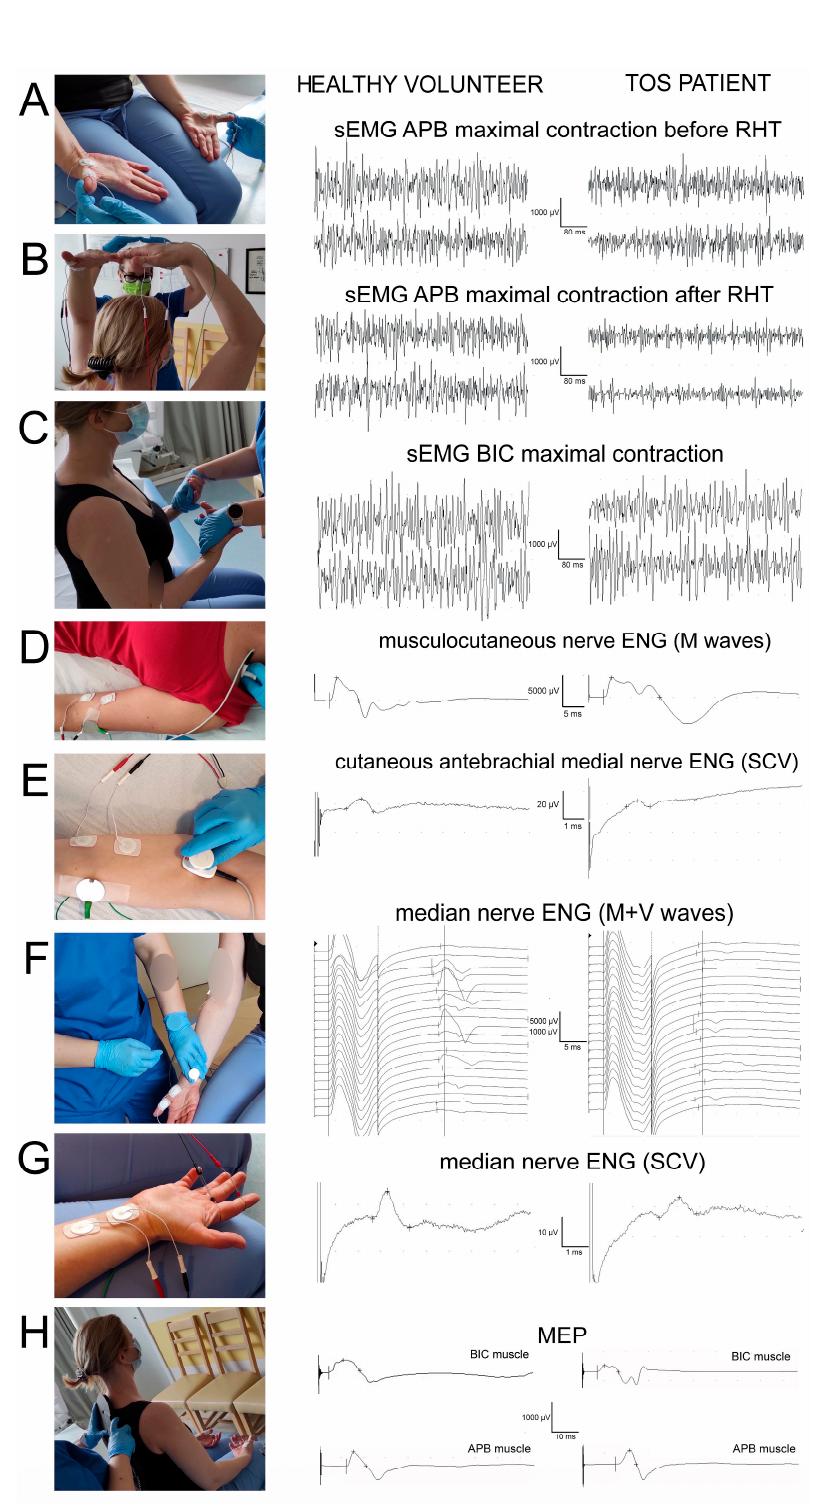
Figure 1. Photographs illustrating the principles of: ( A – C ) surface electromyography (sEMG), ( D – G ) electroneurography (ENG), and ( H ) motor-evoked potential (MEP) of recordings. ( A – H ) Ex- amples of the original, representative recordings of each of the applied neurophysiological tests performed in one of the healthy volunteer subjects and the TOS patients for comparison. Details of sequentially performed neurophysiological tests, forming the diagnostic algorithm proposed in this study, facilitated the differential diagnosis of TOS detection, and are presented in the Materials and Methods section. Calibration bars for different amplifications and time bases are